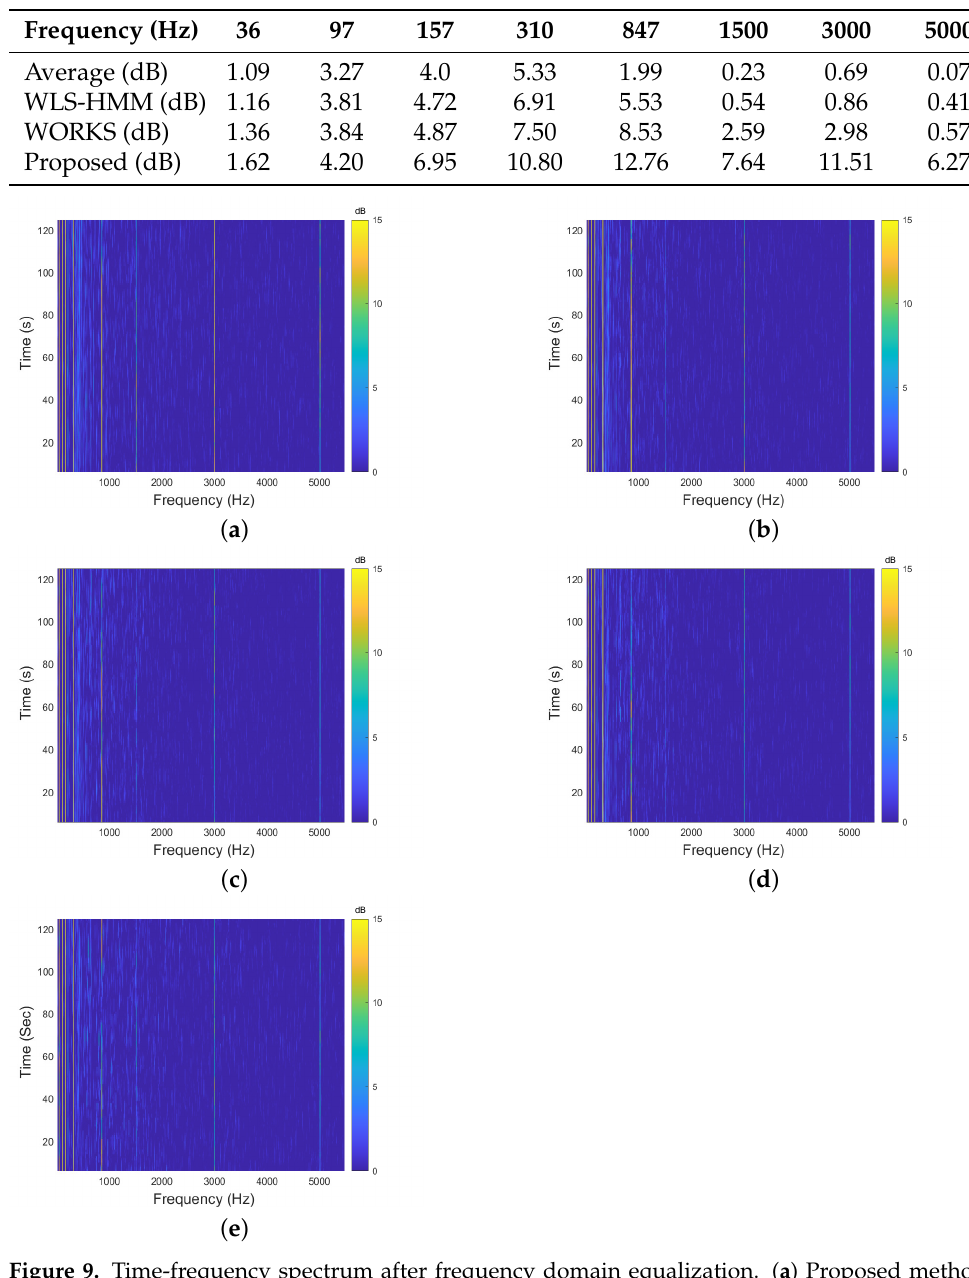
Figure 9. Time-frequency spectrum after frequency domain equalization. ( a ) Proposed method. ( b ) WORKS method. ( c ) WLS-HMM method. ( d ) Average method. ( e ) CBF